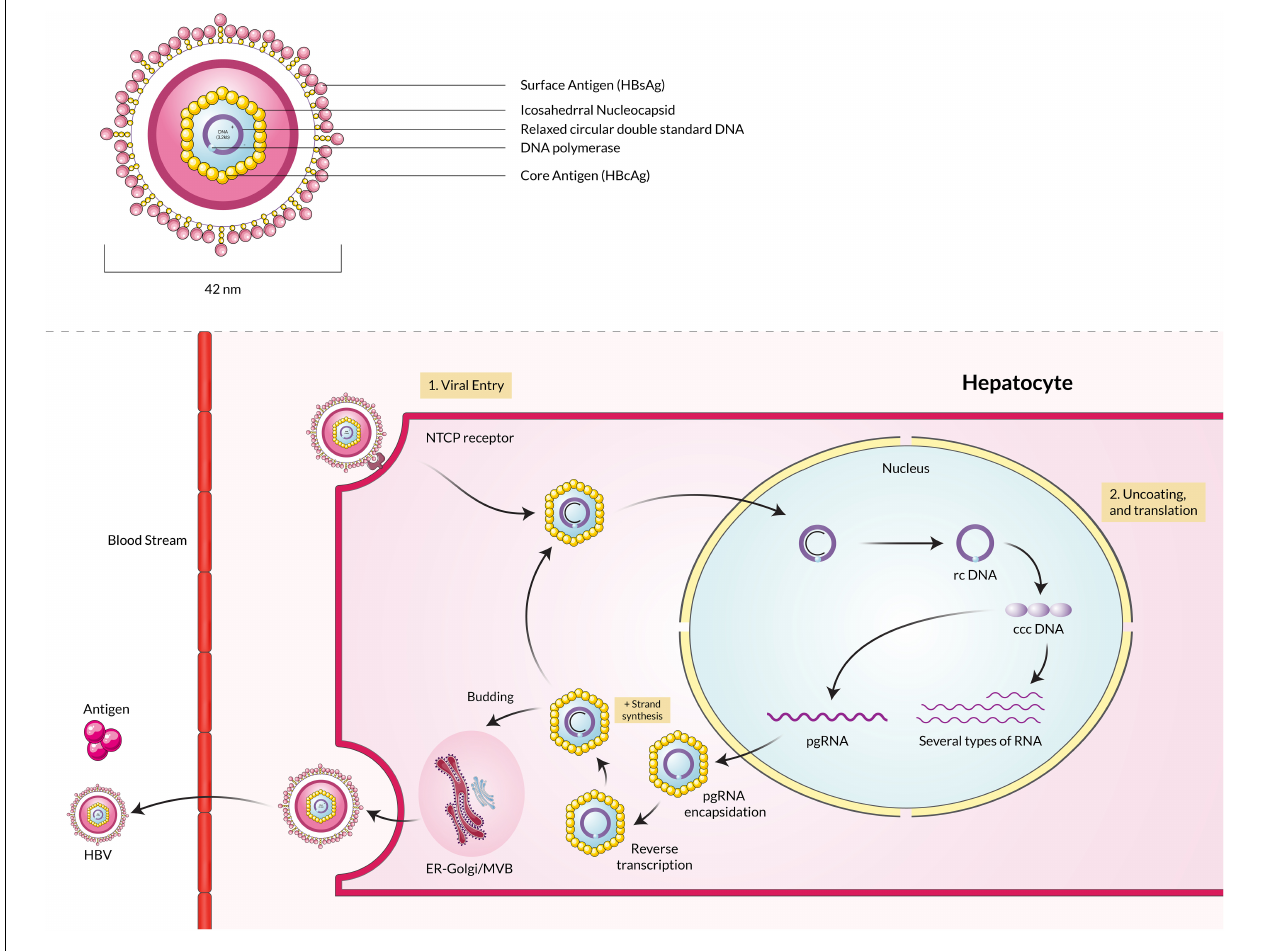
FIGURE 2 | Hepatitis B virus particle binds with the NTCP receptor, fuses with the membrane, and enters the host cell. The rcDNA is converted into cccDNA, transcribed into pgRNA, and finally packaged into the capsid. The capsid is enveloped by the ER-Golgi/MVB and released into the extracellular